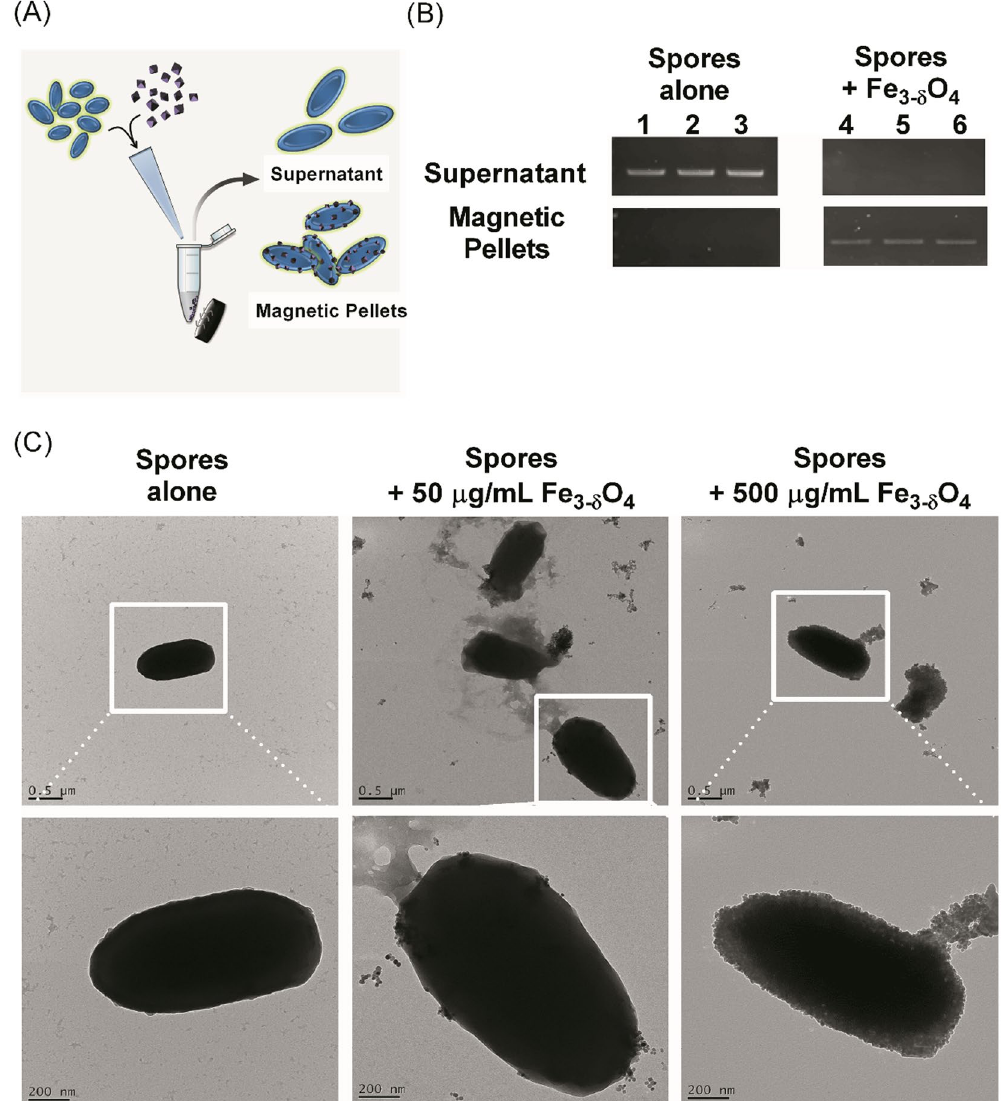
Figure 5. Fe 3- δ O 4 nanoparticles bound to the surface of C . difficile (ATCC BAA-1805) spores, which allowed magnetic attraction. ( A ) Schematic illustration of the magnetic separation of spores with which Fe 3- δ O 4 nanoparticles had bound: these spores were attracted by a magnet, but spores with which the nanoparticles had not bound were retained in the supernatant. ( B ) The spores were incubated for 20 minutes with Fe 3- δ O 4 nanoparticles, and then tcdB genes were isolated from the supernatant or the magnetically concentrated precipitates were detected after PCR amplification. Lanes 1–3 are spores alone and lanes 4–6 are spores treated with 500 µ g/mL of Fe 3- δ O 4 nanoparticles. TcdB amplicons were detected in the supernatant of the control group, but they were found only in the magnetically concentrated fraction after they had been treated with Fe 3- δ O 4 nanoparticles. ( C ) TEM images of the spores (upper panel: 10,000 × ; lower panel: 30,000 × ). The left image shows that native spores have a smooth coat; accumulated Fe 3- δ O 4 nanoparticles on spore surfaces are evident after incubation. The spores treated with 500 µ g/mL were completely covered by the Fe 3- δ O 4